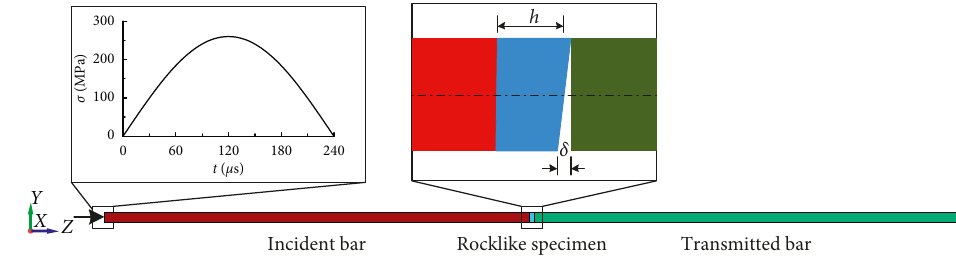
Figure 1: A schematic diagram of SHPB setup in the 3D finite element